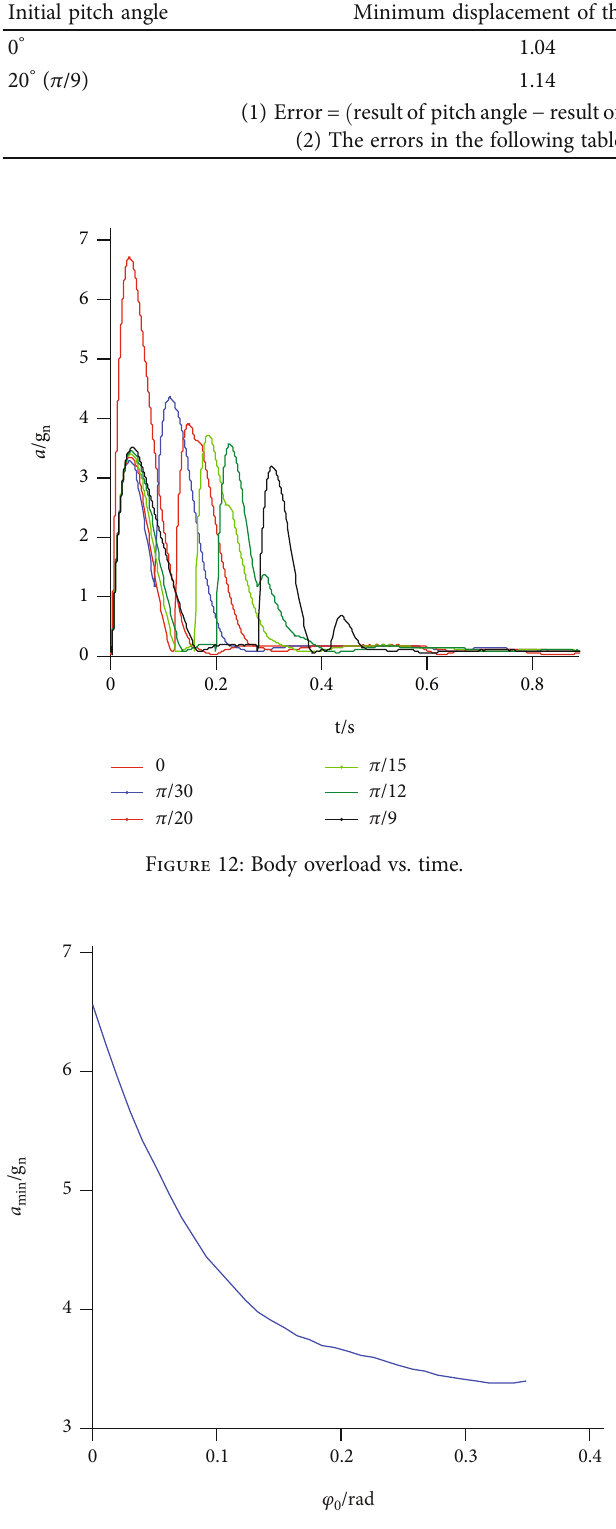
Figure 13: Maximum of body overload vs. initial pitch angle.